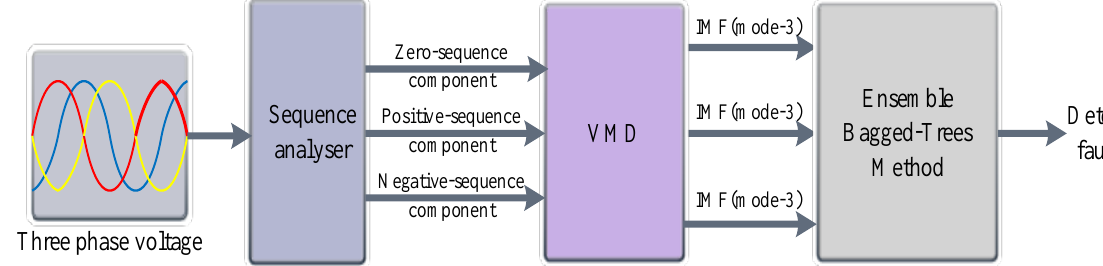
Figure 1. Proposed fault detection structure.